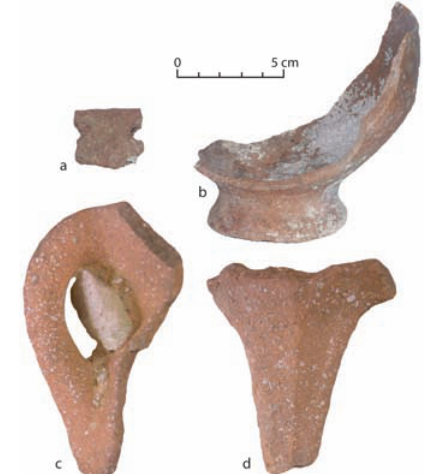
Figure 5 Prehistoric pottery: a) a fragment of a Final Neolithic ‘cheesepot’, b) an Early Bronze 2 ‘sauceboat’, c-d) two fragments of a Minoan tripod cooking pot.